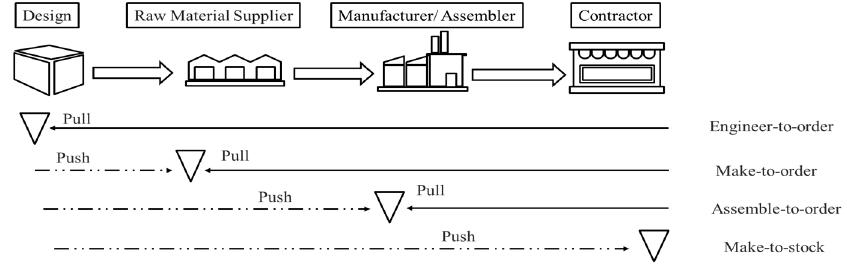
Figure 1. Supply chain strategies in the construction sector (adapted from: [10]).